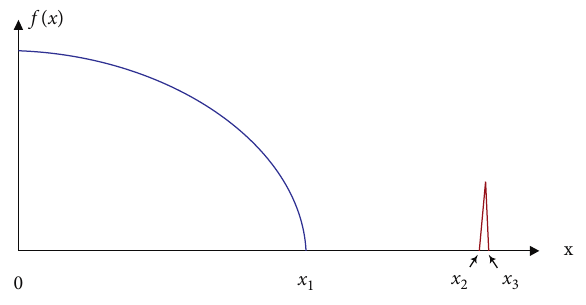
Figure 7: Example of the behavior of the function f ( x )